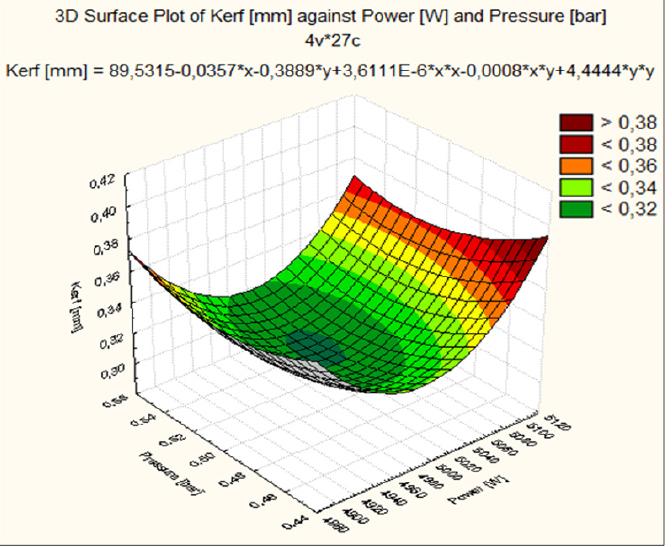
Figure 10. Graph of the quadric dependence of the cutting width on the laser power and the assist gas pressure.